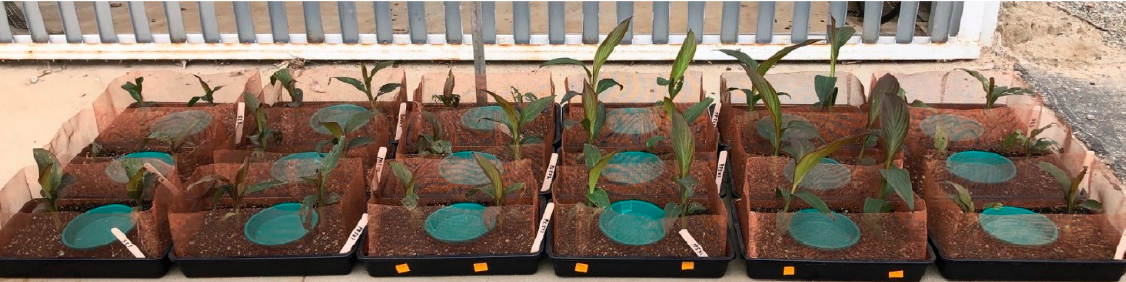
Figure 3. Plant stands of Canna ‘Cannova ® Bronze Scarlet Canna Lily’ 21 days after exposure to Deroceras reticulatum (10 slugs/arena) and treatment with three Phasmarhabditis spp. at 150 infective juveniles/cm 2 duringtrial 1. From left to right the treatments are: Sluggo Plus ® , P. hermaphrodita , P. californica , P. papillosa , No slug or nematodes control, and slug only control. Photo taken at the conclusion of the 1 st lath house trial, on 6 June 2019.